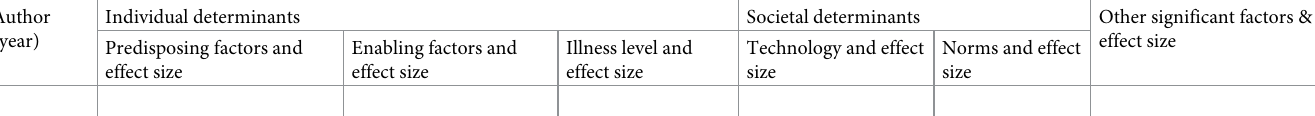
Table 2. Statistically significant determinants of ED utilisation based on multivariable analysis (dummy table).